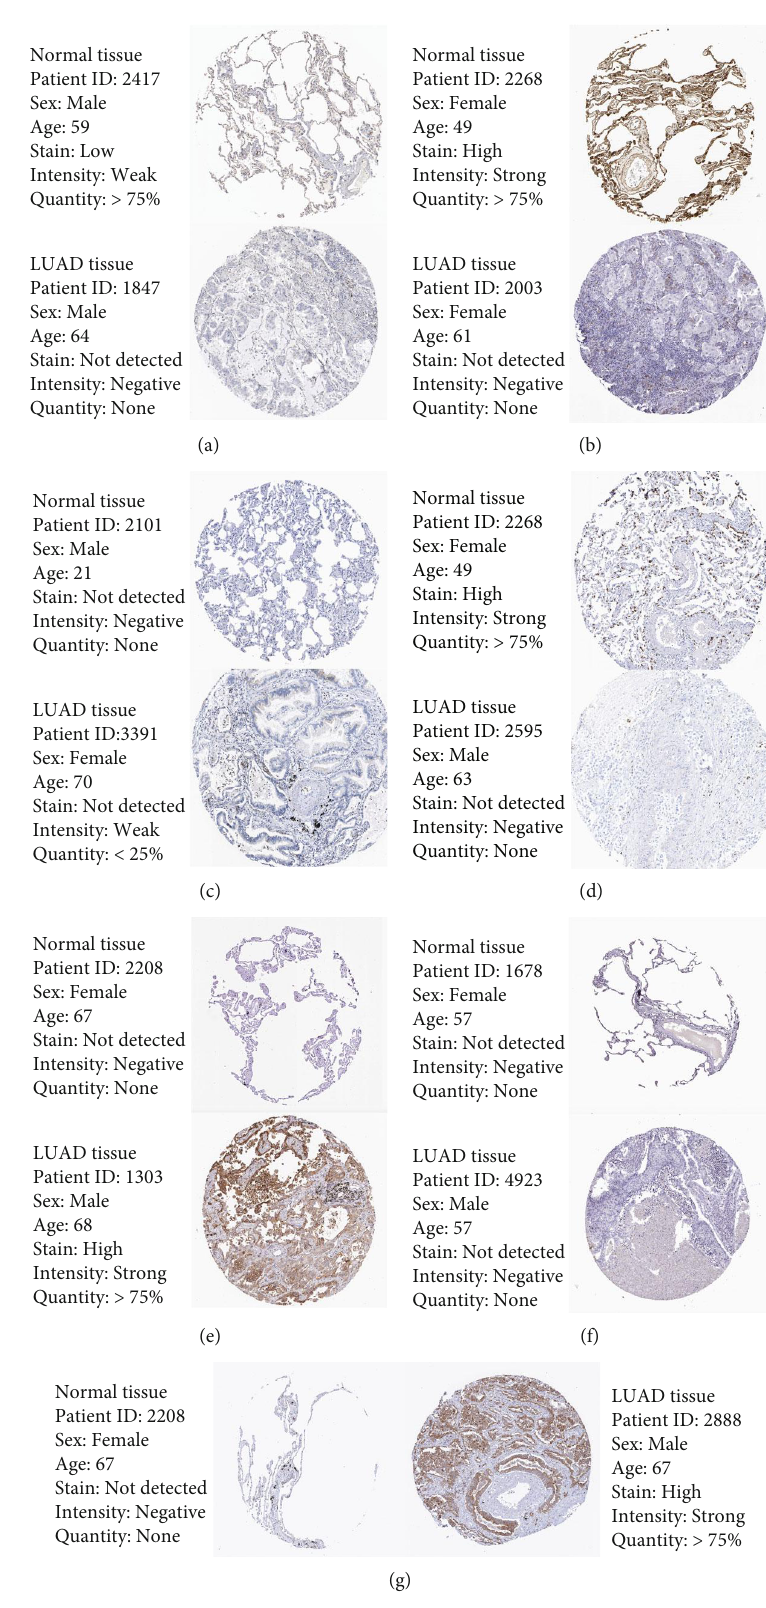
Figure 8: HPA database. (a) ADRB2. (b) AGER. (c) GJB2. (d) SFTPC. (e) SLC2A1. (f) SLC6A4. (g)